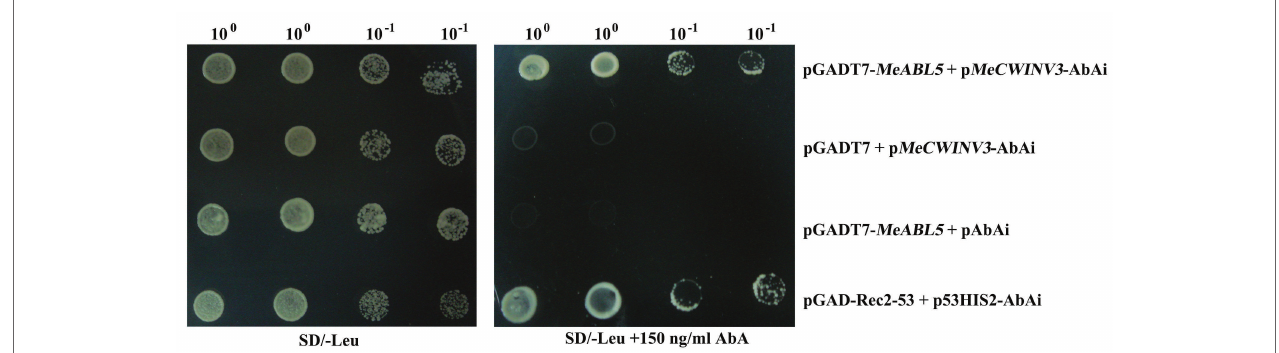
FIGURE 1 | Activation of the MeCWINV3 promoter in yeast by MeABL5. pGADT7-MeABL5 + pMeCWINV3-AbAi shows that MeABL5 can bind to promoter of MeCWINV3; pGADT7-Rec2-53 + p53HIS2-AbAi is the positive control and pGADT7 + pMeCWINV3-AbAi and pGADT7-MeABL5 + pAbAi are the negative controls. Yeast cells were grown in SD/−Leu selective medium containing 0 or 150 ng/ml Aureobasidin A (AbA) for 3 days at